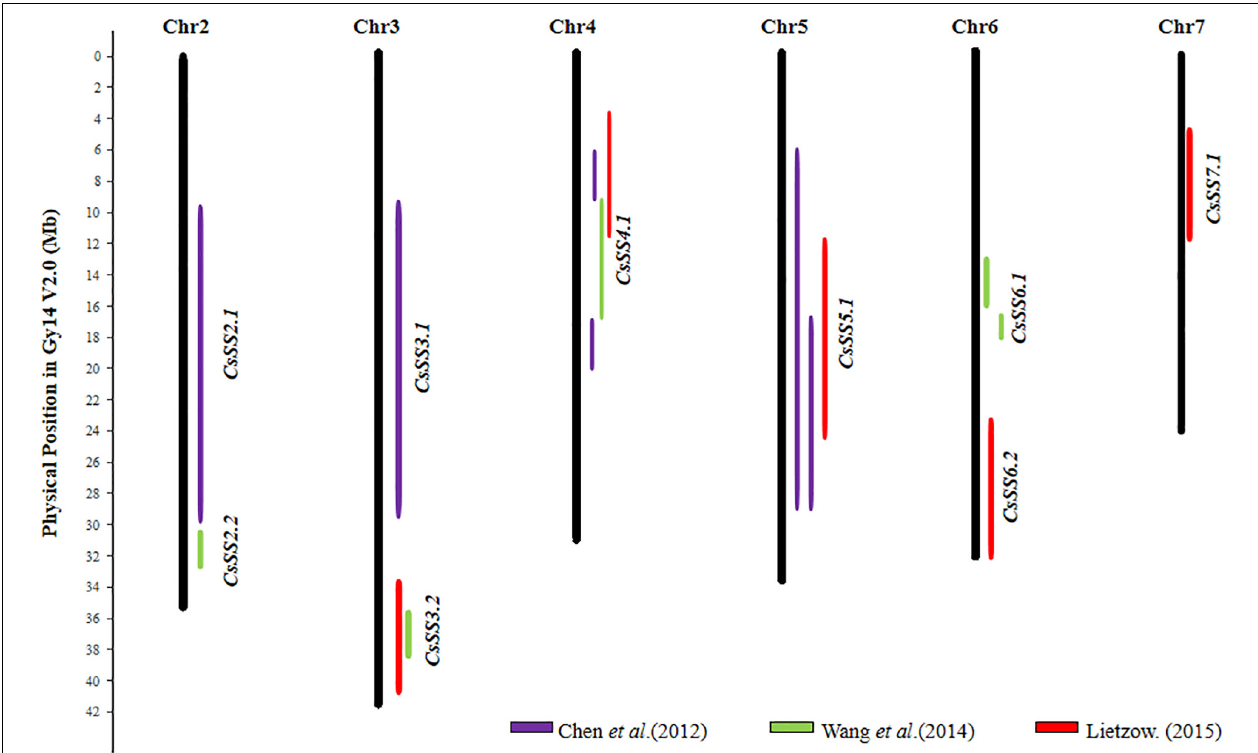
FIGURE 3 | Distribution of 9 seed size (SS) consensus QTL in the cucumber (Gy14 V2.0) draft genome. Physical LOD intervals of QTL identified from different studies are presented to the right of each chromosome. QTL detected by the same study are showed with same color. Only chromosomes harboring seed size QTL are